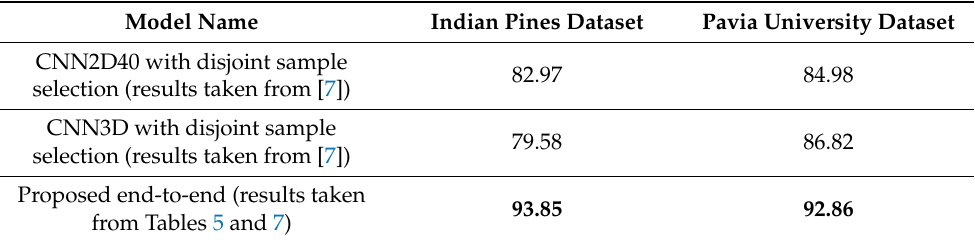
Table 9. Classification accuracy of the proposed method compared to deep learning methods reported in the